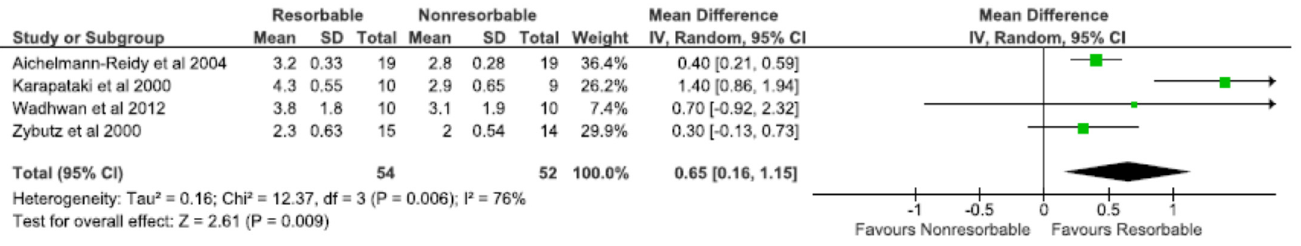
Figure 10. Meta-analysis of intra-bony defect depth (IBDD) at all intervals (6–12